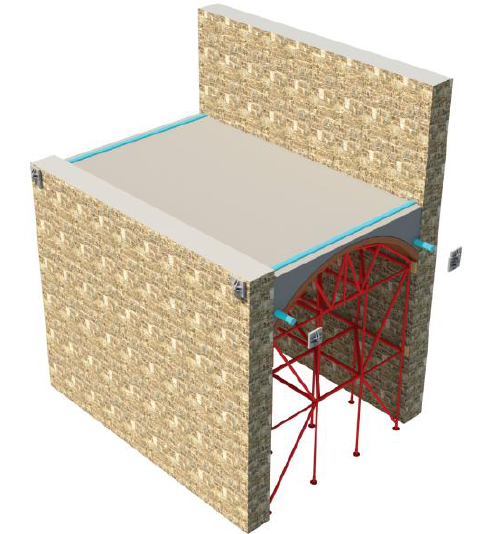
Figure 5: Tie rods insertion model.